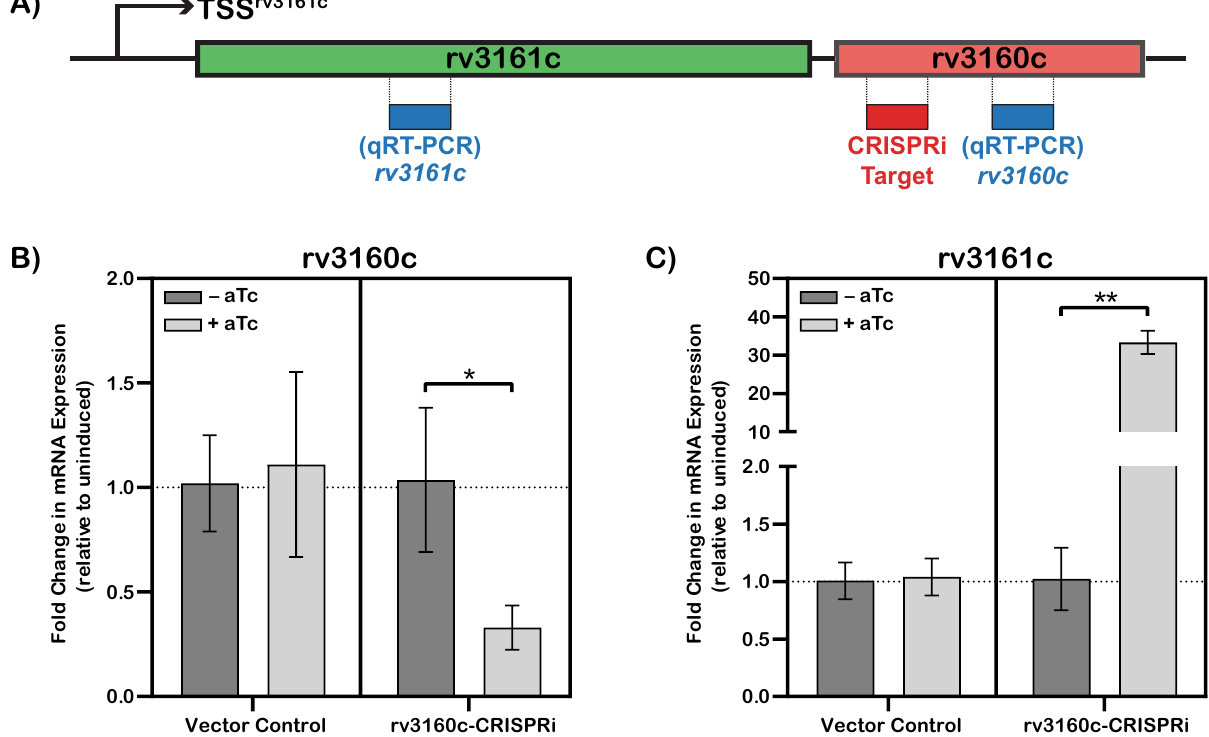
Figure 2. Rv3160c acts as transcriptional repressor of the rv3160c-rv3161c operon. ( A ) Schematic representation of the rv3160c-rv3161c operon and the relative positions of the targets for CRISPRi and qRT- PCR. ( B , C ) qRT-PCR analysis of rv3160c and rv3161c mRNA expression in Mtb Erdman WT strain harboring either vector control (pJR965) or the rv3160c-CRISPRi (pSA253) construct in absence (−) or presence (+) of 100 ng/ml aTc. sigA mRNA expression was used as control and relative fold change in rv3160c and rv3161c mRNA expression were calculated for each biological replicate by the Livak (2 −ΔΔCt ) method. Average value of 3 technical replicates was used for each biological replicate. Bar graphs were plotted based on average and standard deviation obtained from three independent biological replicates and statistical analysis was determined by one-tail t -test that was performed using GraphPad Prism version 8.4.3 for Windows, GraphPad Software, San Diego, California USA, www.graph pad.com (* p < 0.05, ** p <